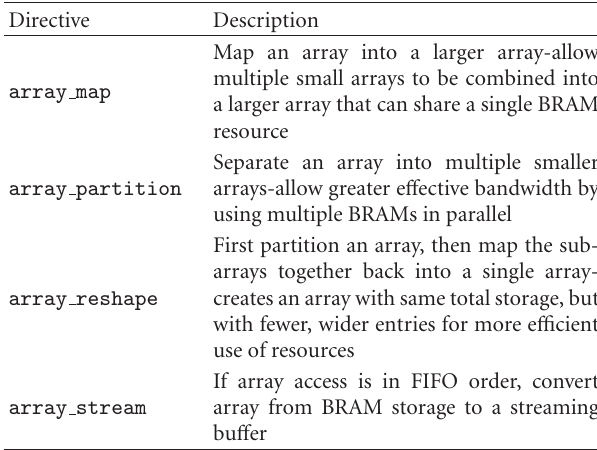
Table 4: Data Array